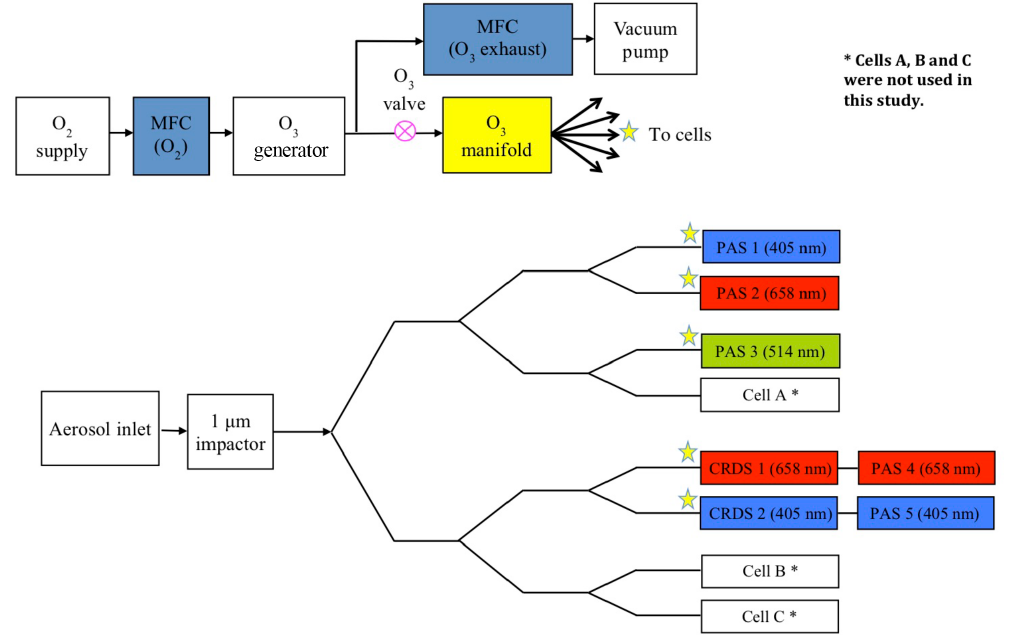
Figure 1. Schematic diagram of the PAS/CRDS experimental set-up including the ozone generation system and the relative positions of the PAS and CRDS cells. The stars indicate the ozone flow path, which entered the cells through different ports to the main aerosol flow. The PAS/CRDS wavelengths are centred at 405, 514 and 658nm respectively. Abbreviations: MFC is mass flow controller.